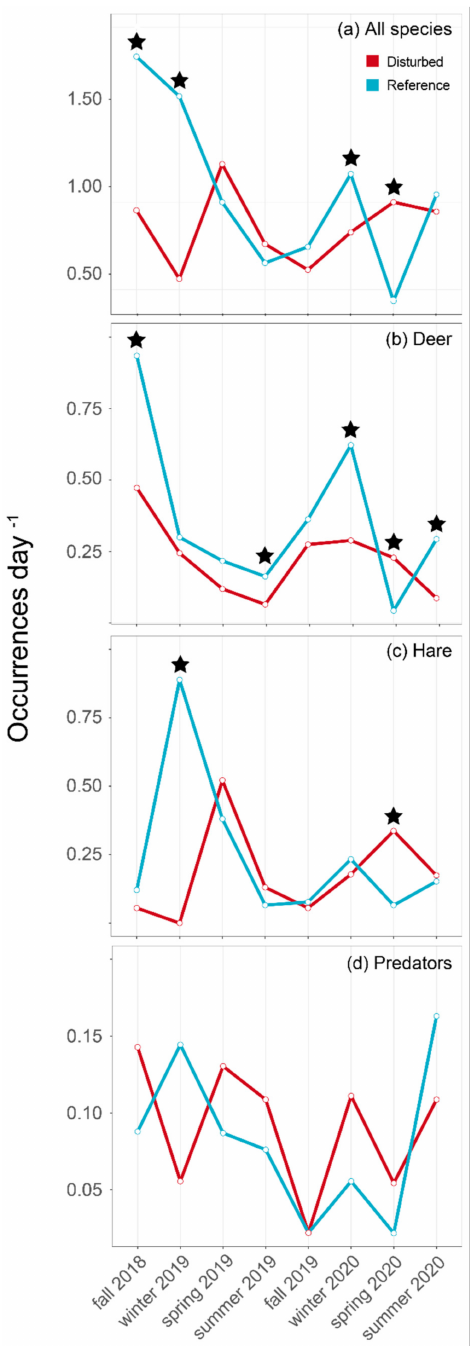
Figure 4. Occurrences per day for ( a ) all species, ( b ) deer, ( c ) hare, and ( d ) all predators combined (coyote, bobcat, fisher and red fox) from fall 2018 to summer 2020 for the reference and disturbed forest conditions. Stars indicate a significant difference ( p ≤ 0.05) between forest conditions based on chi-square tests. Note scale differences on